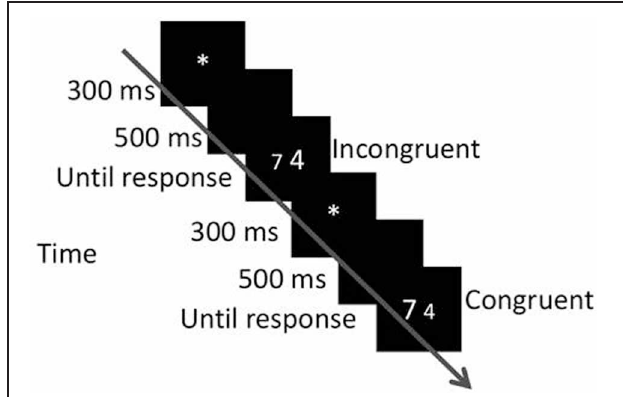
FIGURE 3 | Procedure of Experiment 2. Trials in these blocks were either congruent or